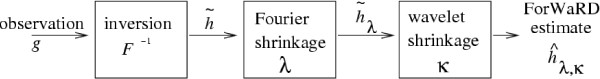
ForWaRD HRF extraction scheme. Fourier shrinkage (determined by λ) is applied to partially attenuate noise amplified during the inversion step. Subsequent wavelet shrinkage (determined by κ) effectively attenuates the residual noise.